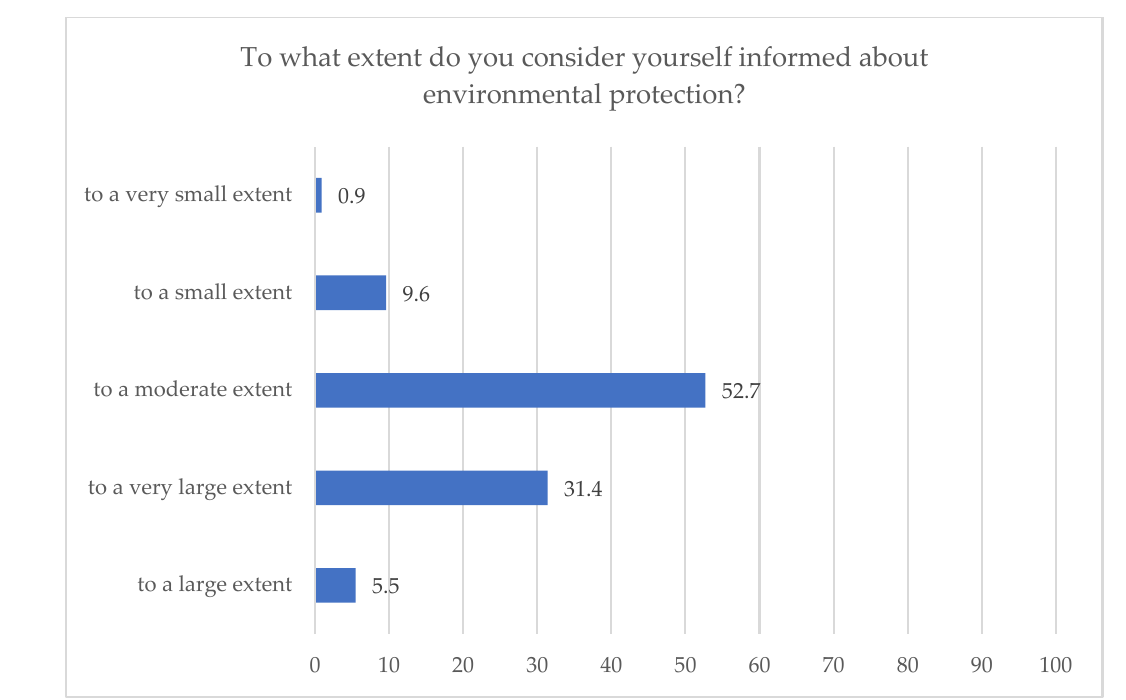
Figure 2. Respondents’ awareness of environmental protection.